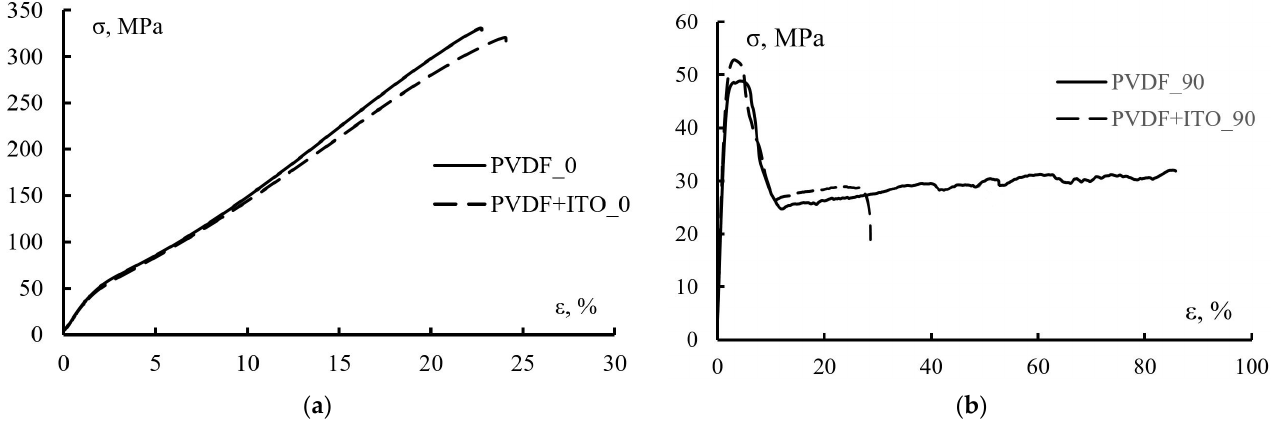
Figure 9. Typical load diagrams for the original and coated PVDF fi lms in directions 0 ( a ) and 90 ( b ).